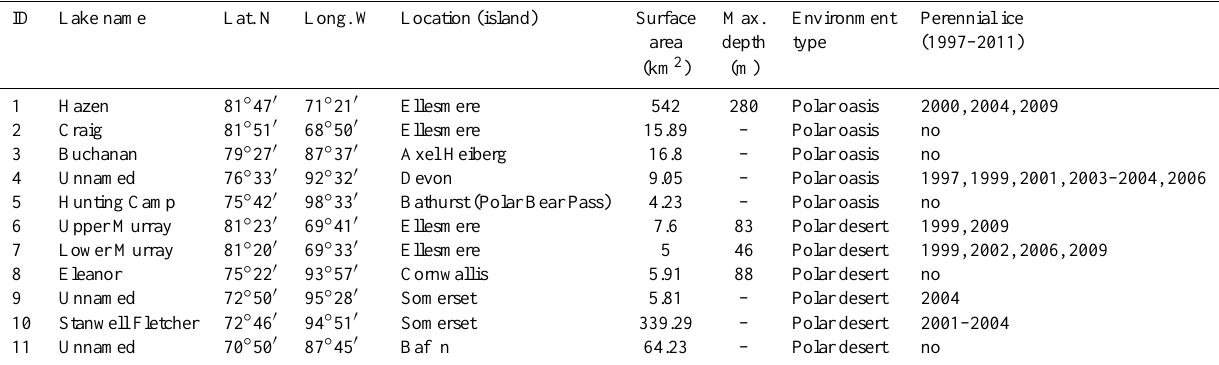
Table 1. Location and basic characteristics of study